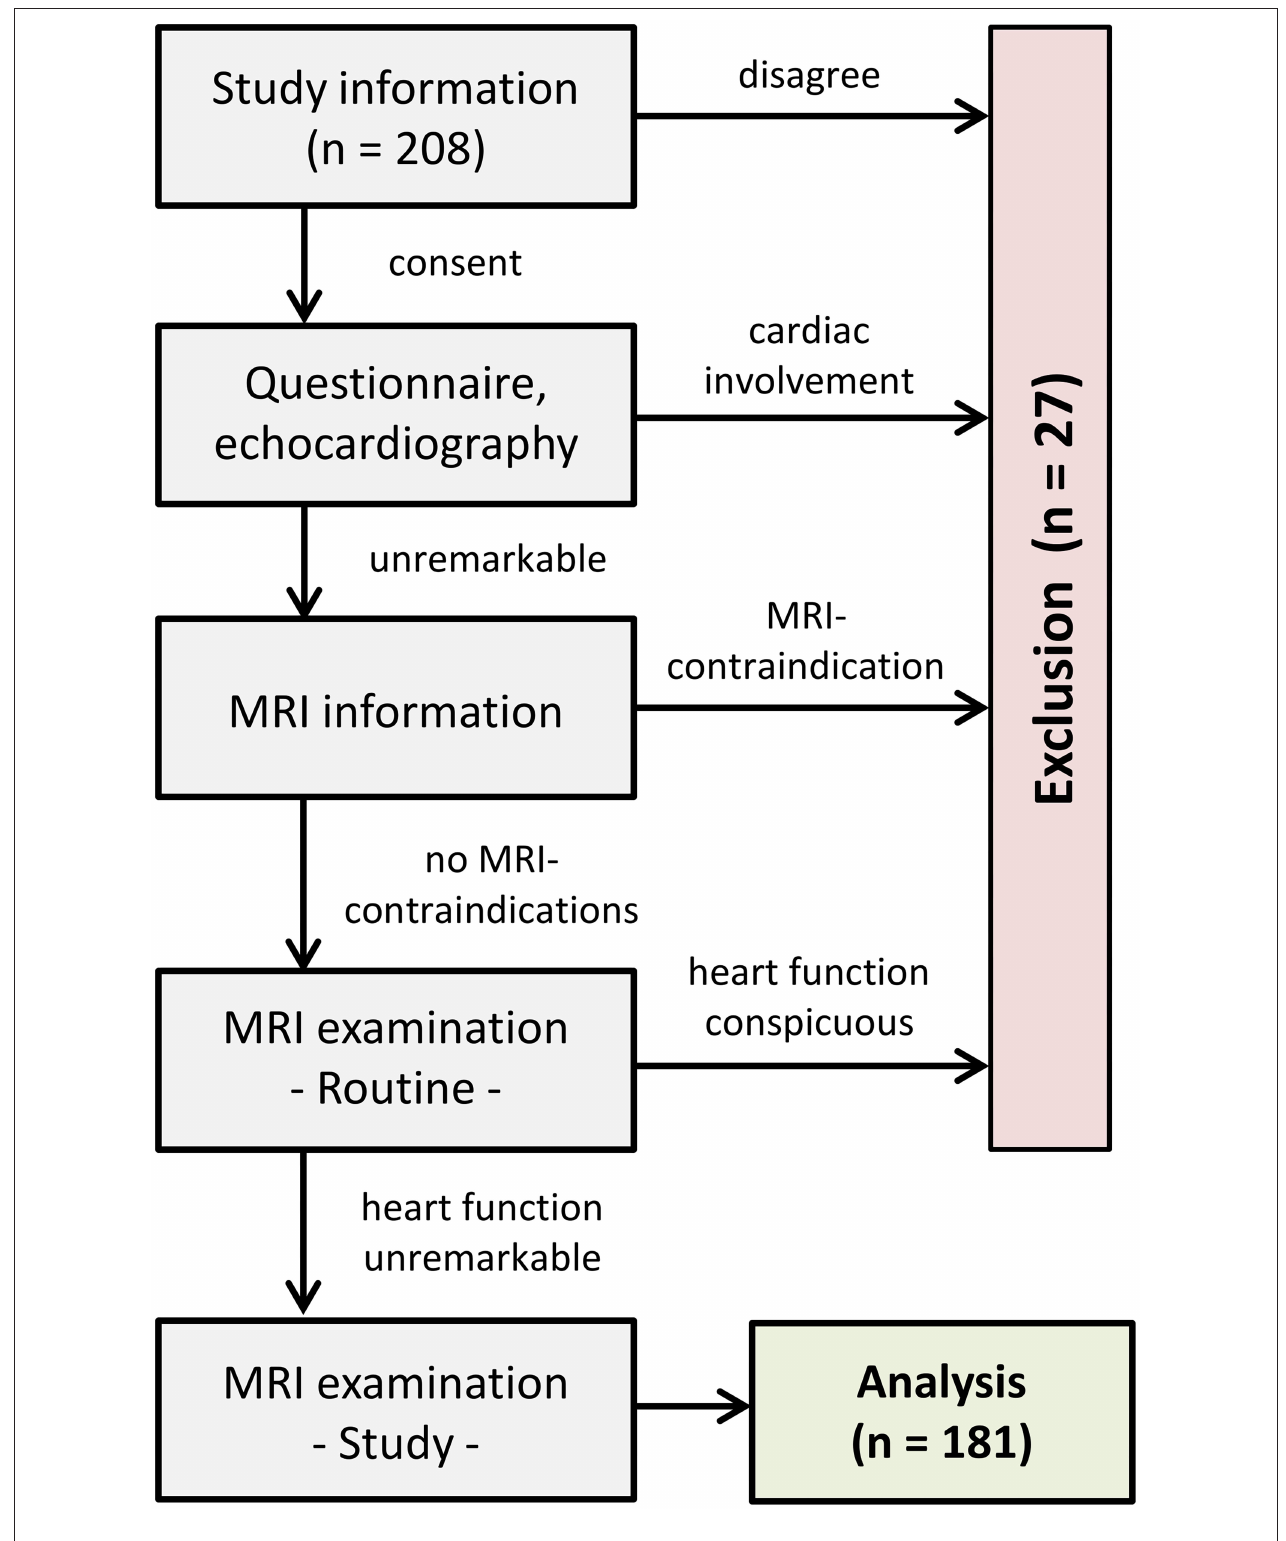
FIGURE 1 | Flow chart of study procedure.